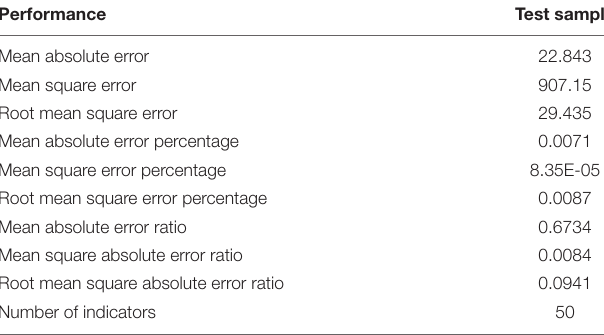
TABLE 4 | ANN model performance evaluation form.